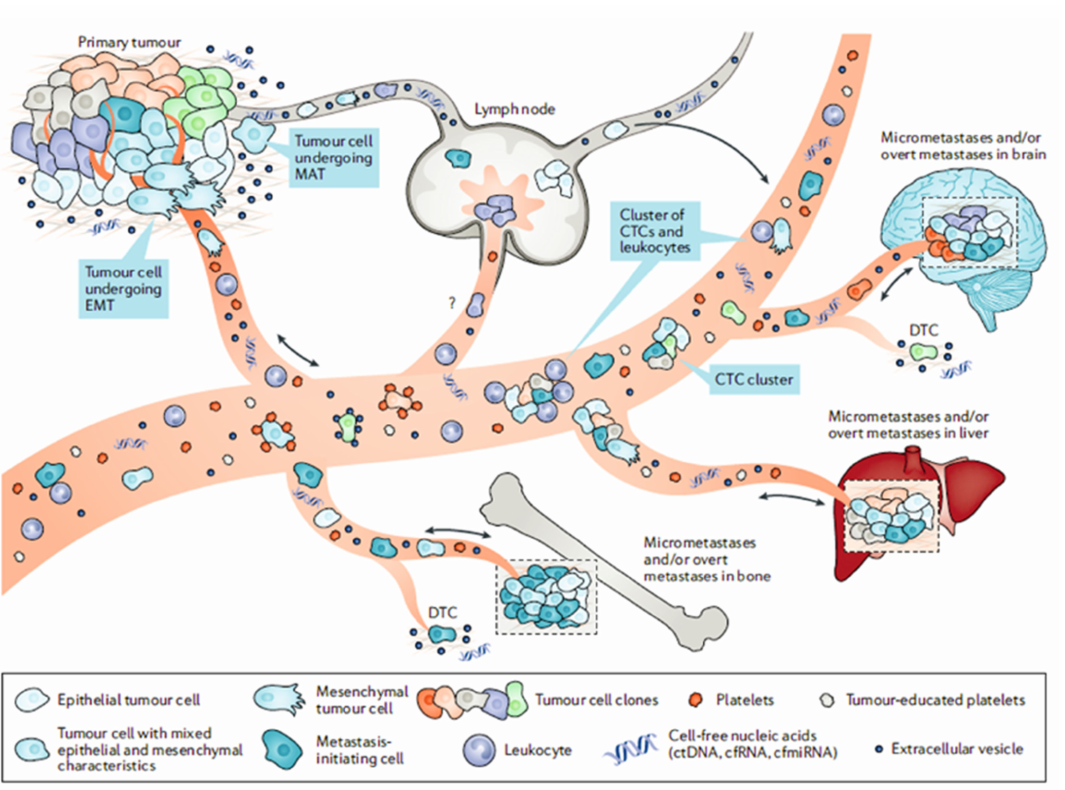
Figure 1. Schematic representation of tumor dissemination: CTCs are released in the circulatory system via several entry sites; in the blood, there is a high CTCs heterogeneity; different extravasation sites for CTCs regarding tumor type. Reprinted by permission from Springer Nature Ltd.: Nat.